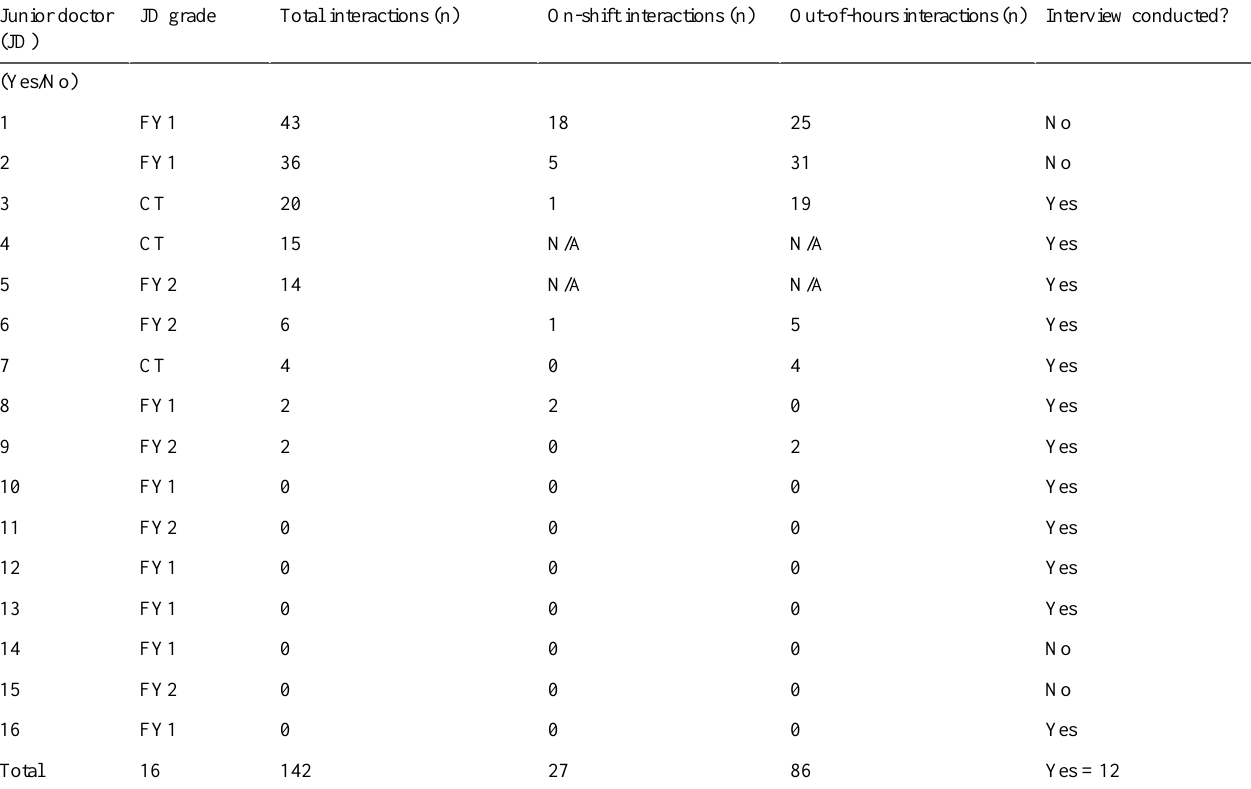
Table 2. Recorded interactions with clinical decision support on mobile phones among junior